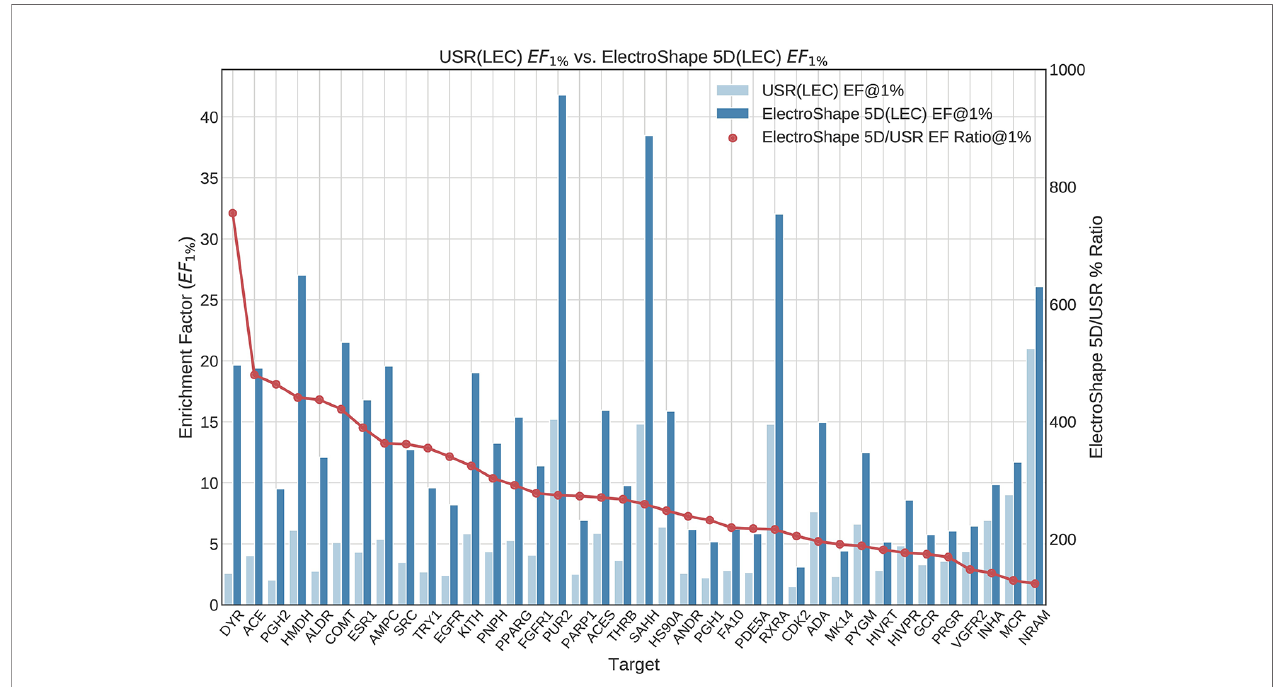
FIGURE 3 | Comparison of Enrichment Factor at 1% obtained by USR with that obtained by ElectroShape 5D using Lowest Energy Conformers. Also plotted is the percentage ratio of the Enrichment Factor score of ElectroShape 5D compared to Ultrafast Shape Recognition (USR). Mean ratio = 283% ± 125%, max = 755%, min = 124%.